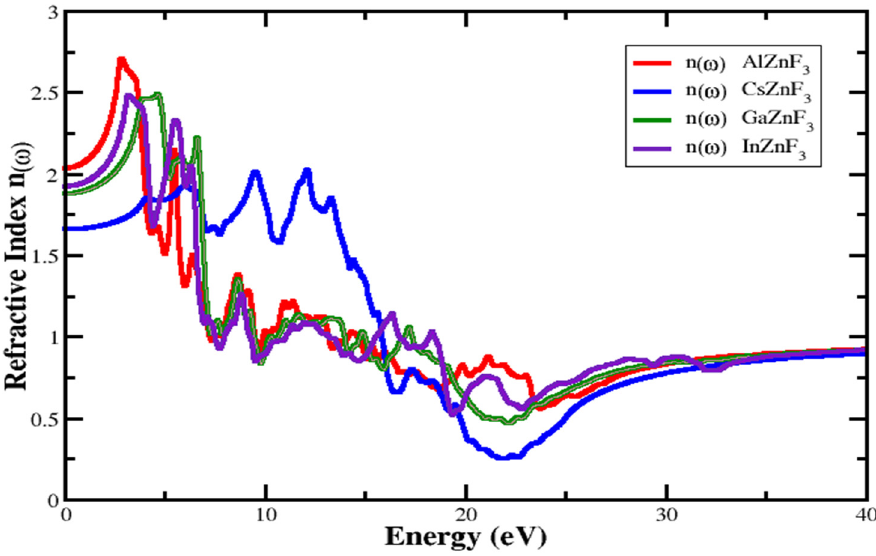
Figure 6. Investigated refractive index n( ω ) of the dielectric function for XZnF 3 (X = Al, Cs, Ga, In).